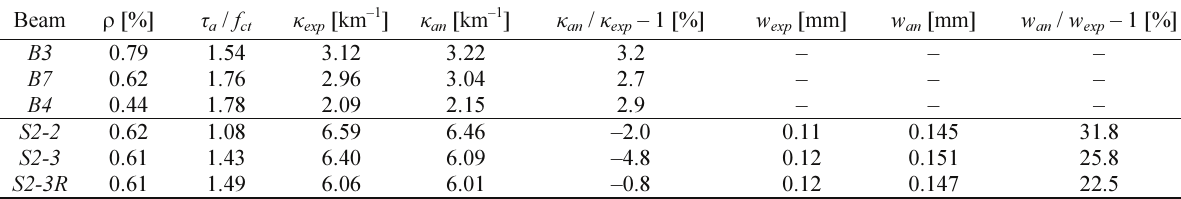
Table 1. The curvatures and average crack widths of the beams at service load